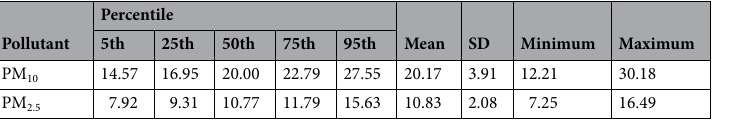
Table 2. Descriptive statistics for PM 10 (μg/m 3 ) and PM 2.5 (μg/m 3 ) during follow-up (2008–2016) in the study cohort. PM10, particles with an aerodynamic diameter of less than 10 µm; PM2.5, particles with an aerodynamic diameter of less than 2.5 µm; SD, standard deviation.